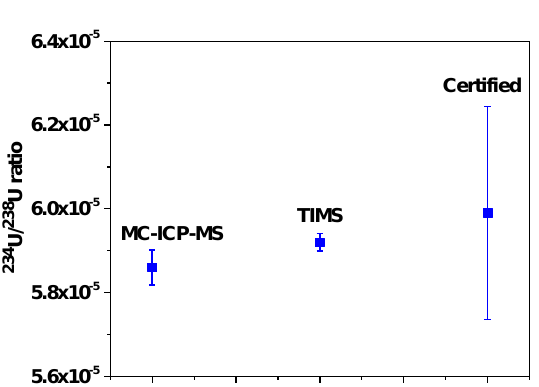
Figure 6. Comparison between measured values and certified values of 234 U / 238 U ratio for National Institute of Standard and Technology (NIST) 4350B.